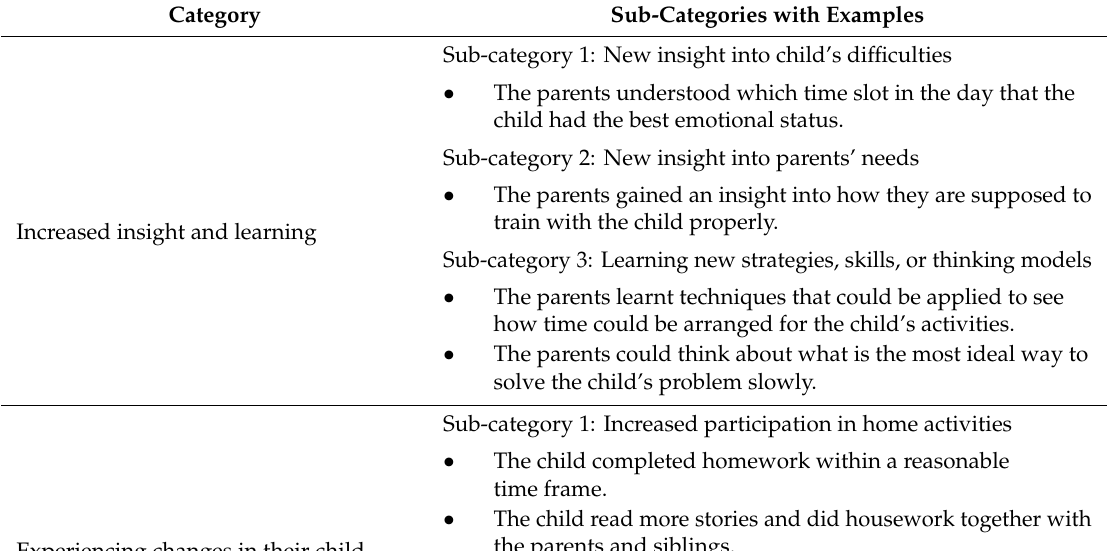
Table 5. Categories and sub-categories for parents’ experience of